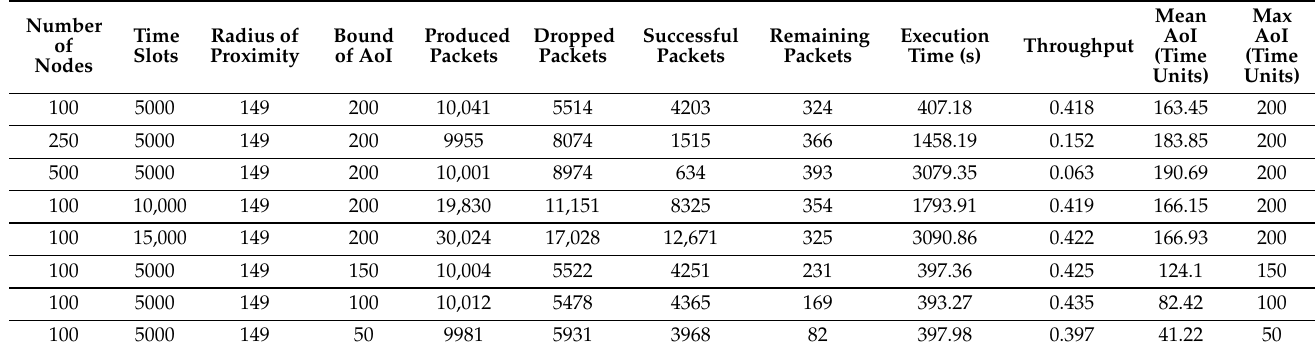
Table 10. Larger scale simulation for Modified-near-v2.